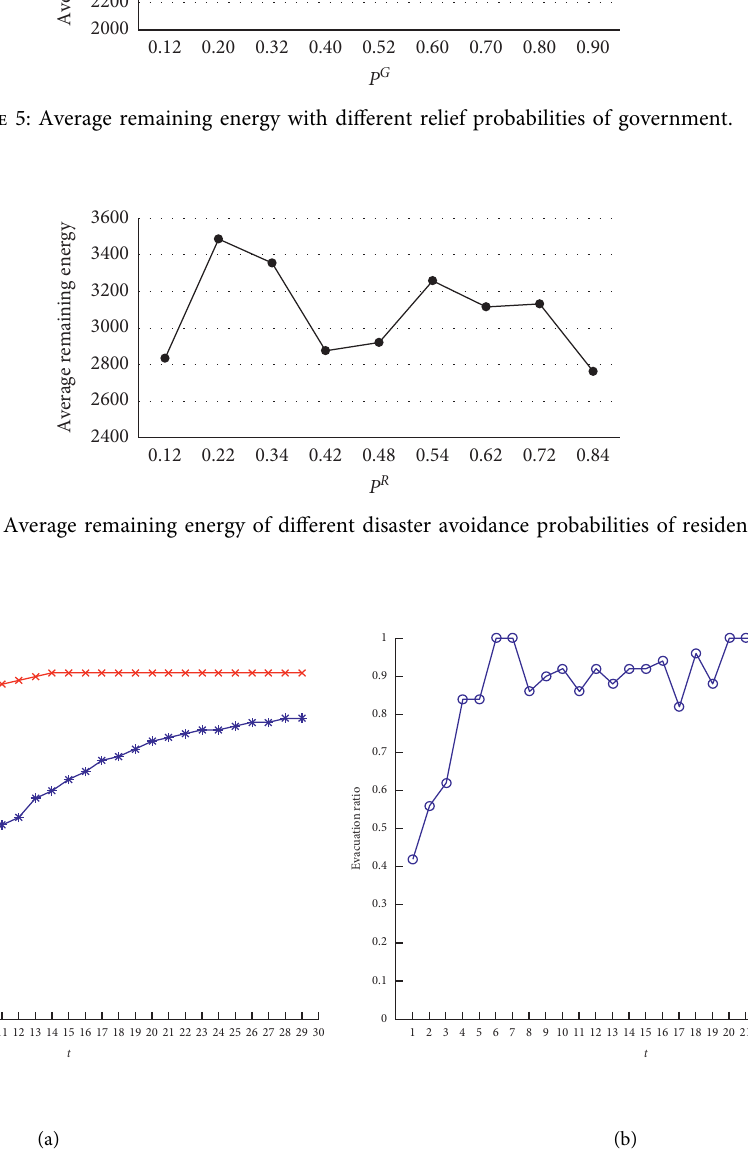
Figure 7: Evolution with initial P R � 0 . 3 and P G � 0 . 3. (a) Evolution of P G and P R . (b) Entire Reaction.